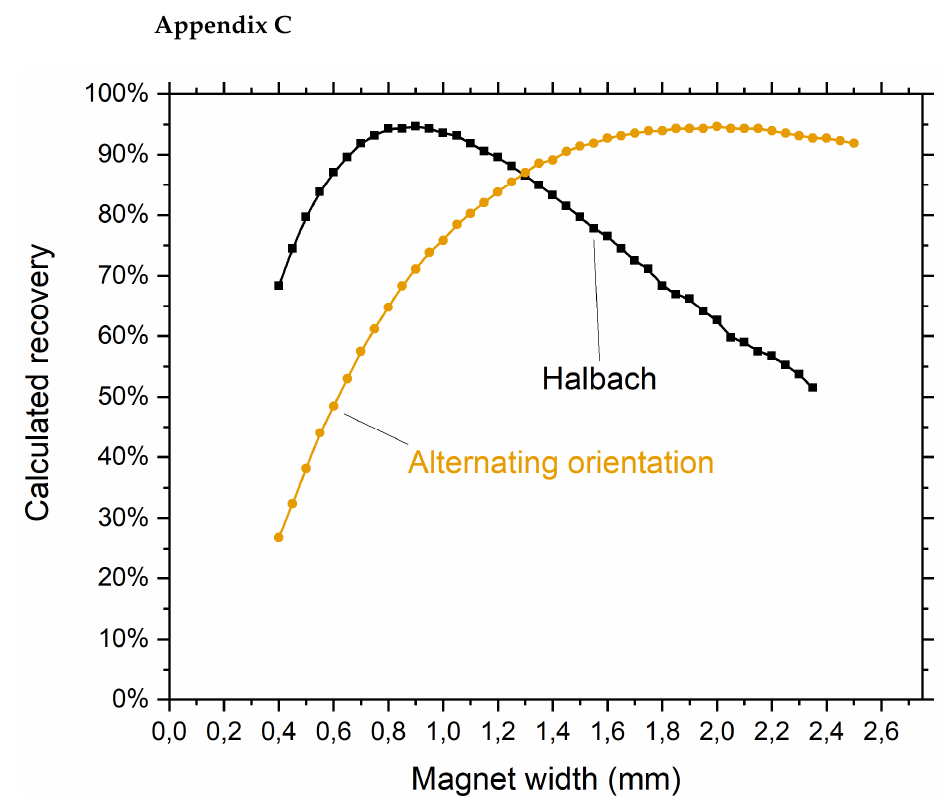
Figure A1. Optimization of magnet width for the Halbach and alternating orientation arrays using a magnet height of 2/2.75 mm and 2.375 mm, respectively. The optimum for the Halbach array is at 1.0 mm while the optimal width for the alternating array is found at 2.0 mm.